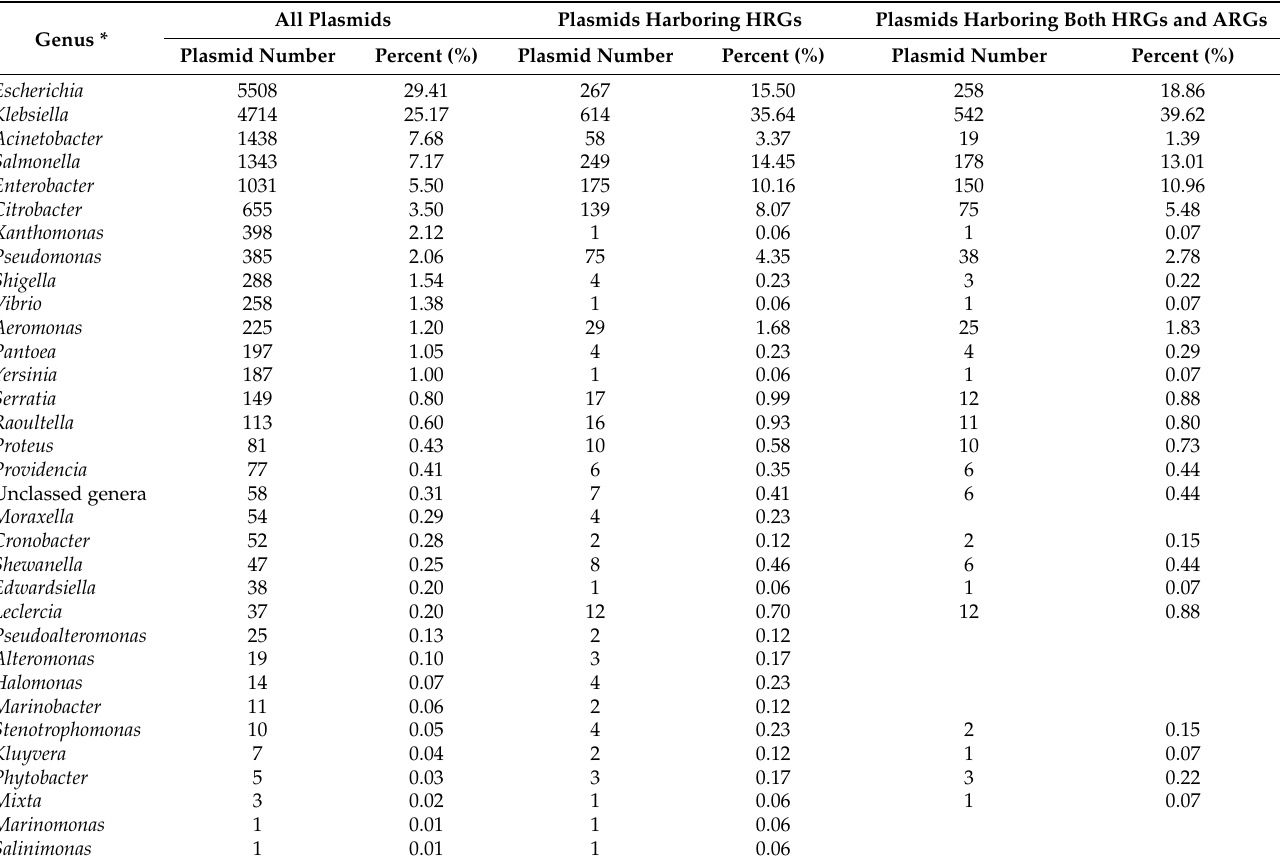
Table 1. Taxonomic distribution of HRGs and ARGs in plasmid